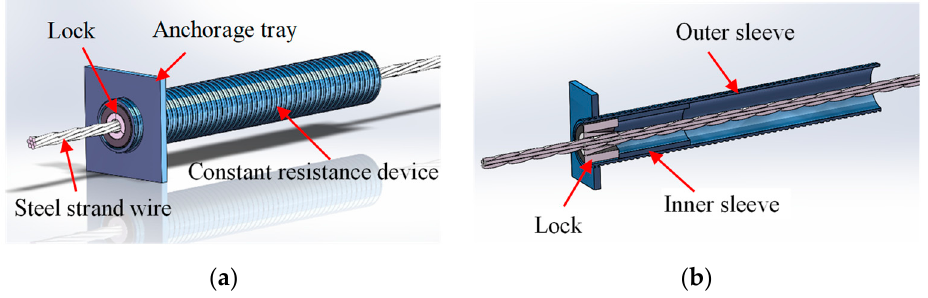
Figure 4. Schematic diagrams of constant resistance and large deformation anchor cable. ( a ) overall structure; ( b ) section structure.